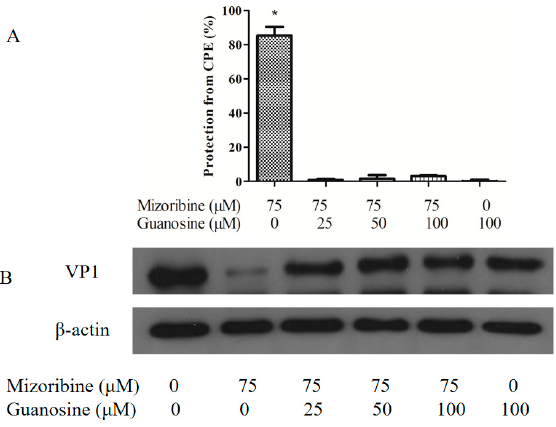
Figure 5. Guanosine supplementation attenuated the anti-FMDV e ff ect of mizoribine. Serial dilutions of guanosine (from 100 to 25 µ M) were added to FMDV (100 TCID 50 O / MY98 / BY / 2010)-infected IBRS-2 cells, when treated with 75 µ M mizoribine for 48 h. ( A ) The cell viability of cells and ( B ) FMDV VP1 levels were analyzed as described above. Data are the mean ± SD of three independent experiments. * p <